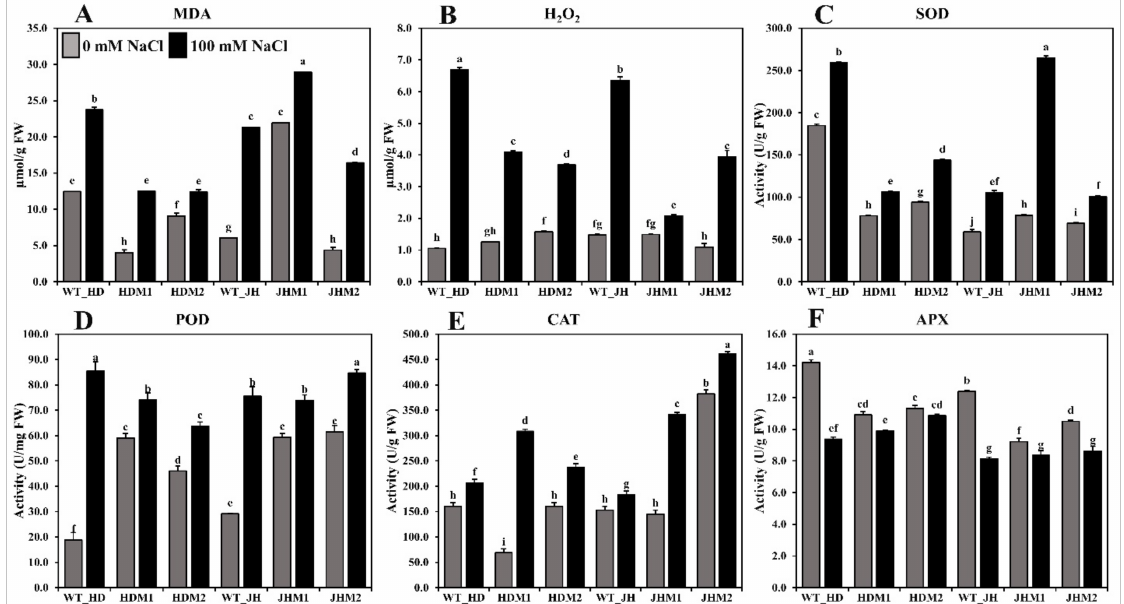
Figure 5. Lipid peroxidation, ROS scavenging, and antioxidant enzyme content in rice seedlings (wild types and mutants). ( A ) MDA content; ( B ) H 2 O 2 content; ( C ) SOD; ( D ) POD (peroxidase); ( E ) CAT; ( F ) APX enzyme activity measurements. All analyses were performed with three biological replicates and three technical replicates and grouped, using the Tukey method. Means that do not share the same letter are significantly different at a 5%